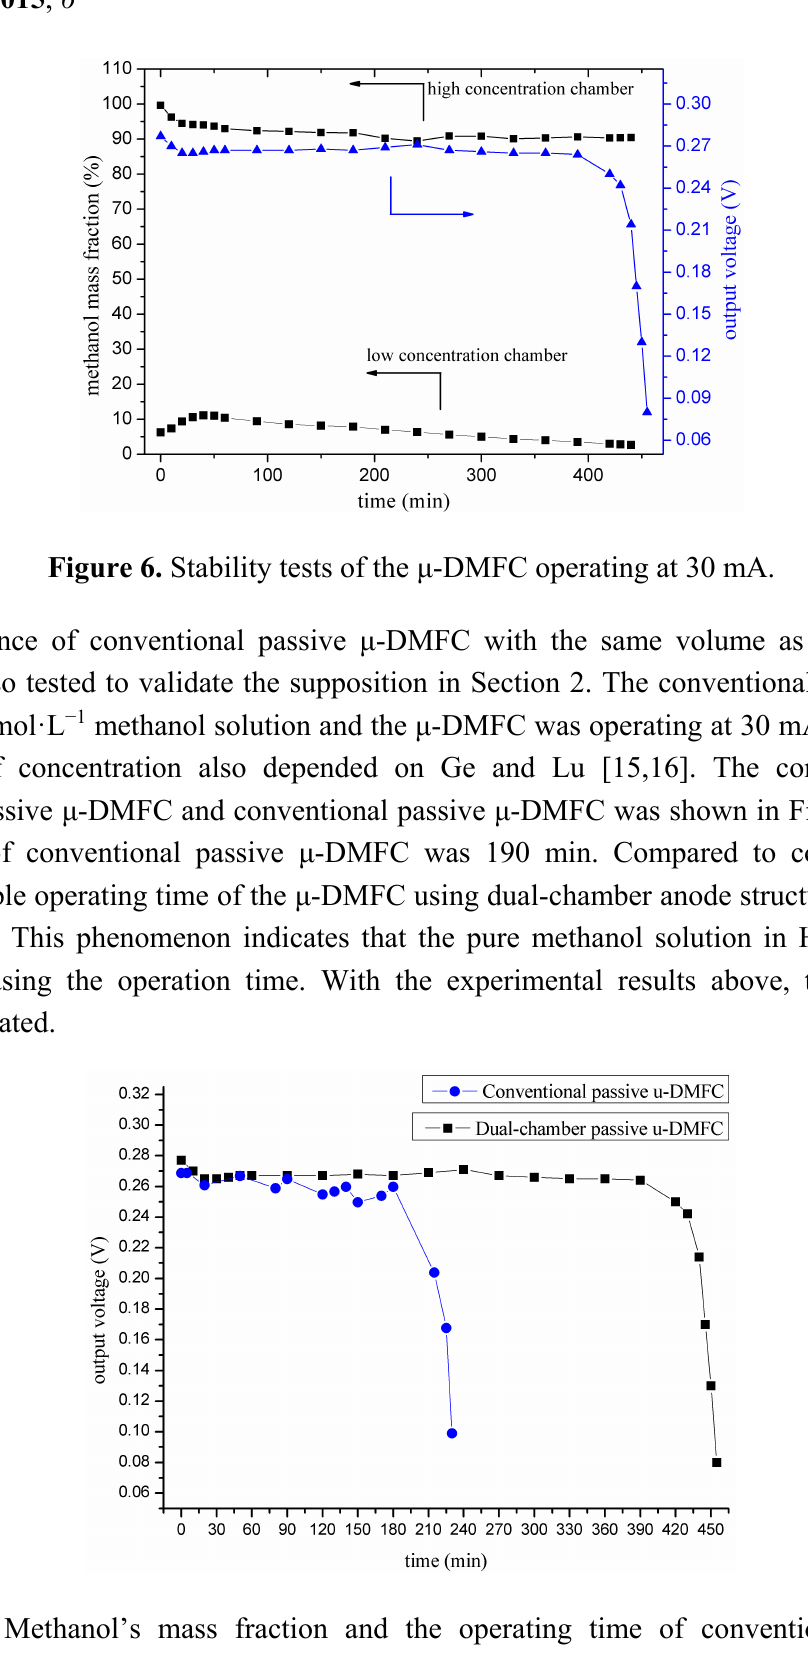
Figure 7. Methanol’s mass fraction and the operating time of conventional passive μ -DMFC fed with 2mol/L methanol